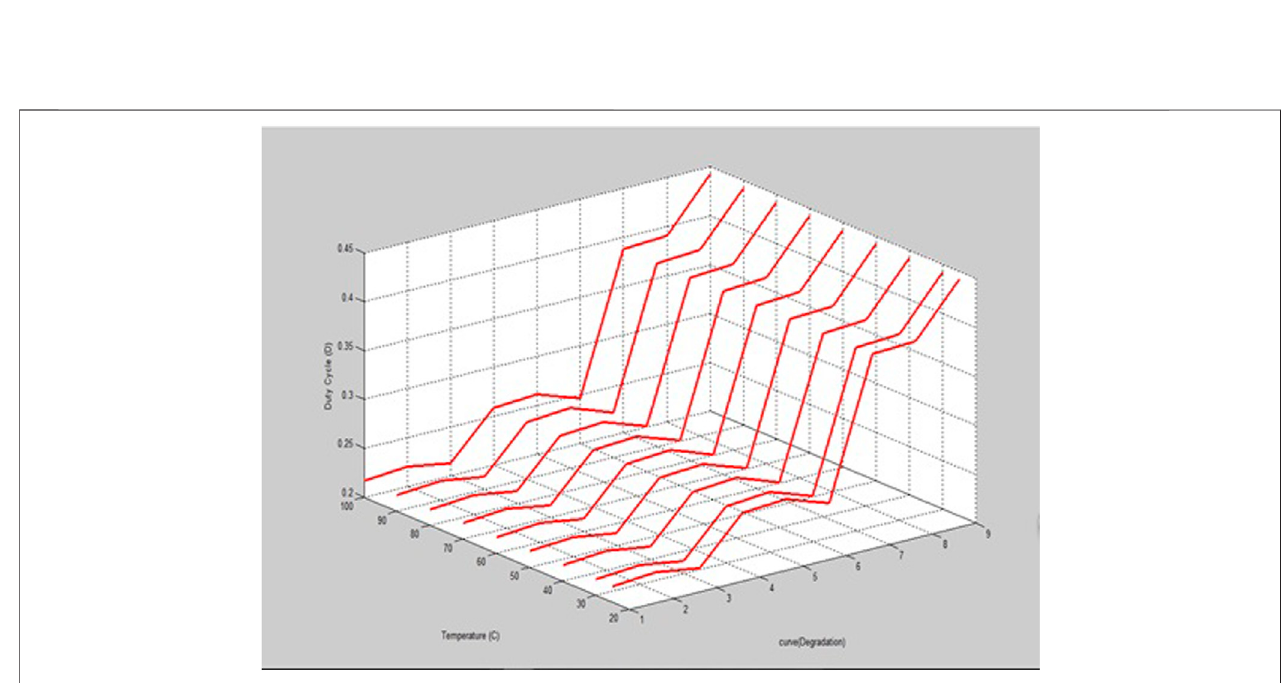
FIGURE 12 | Duty cycle against temperature variation in 3D.